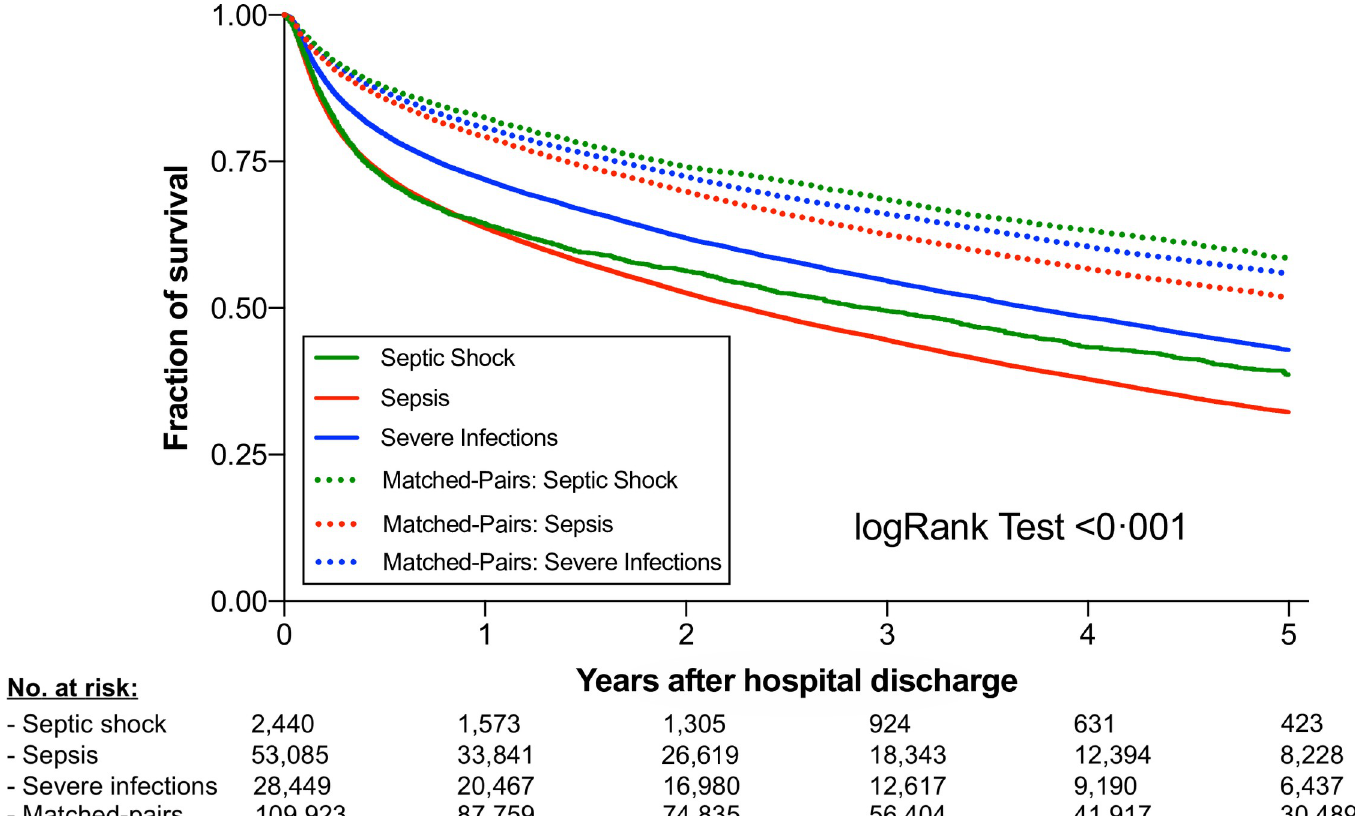
Fig 3. 5-year survival of septic shock, sepsis and severe infections compared to matched pairs. Shown are hospital survivors after suffering from septic shock (green), sepsis (red), or severe infections without organ dysfunction (blue) compared to matched patients with hospitalizations without infection. Kaplan-Meier estimates were used to calculate probabilities of 5-year survival based on the above-mentioned classification. 5-year survival was markedly and significantly decreased in patients having suffered from septic shock, sepsis, and severe infections.